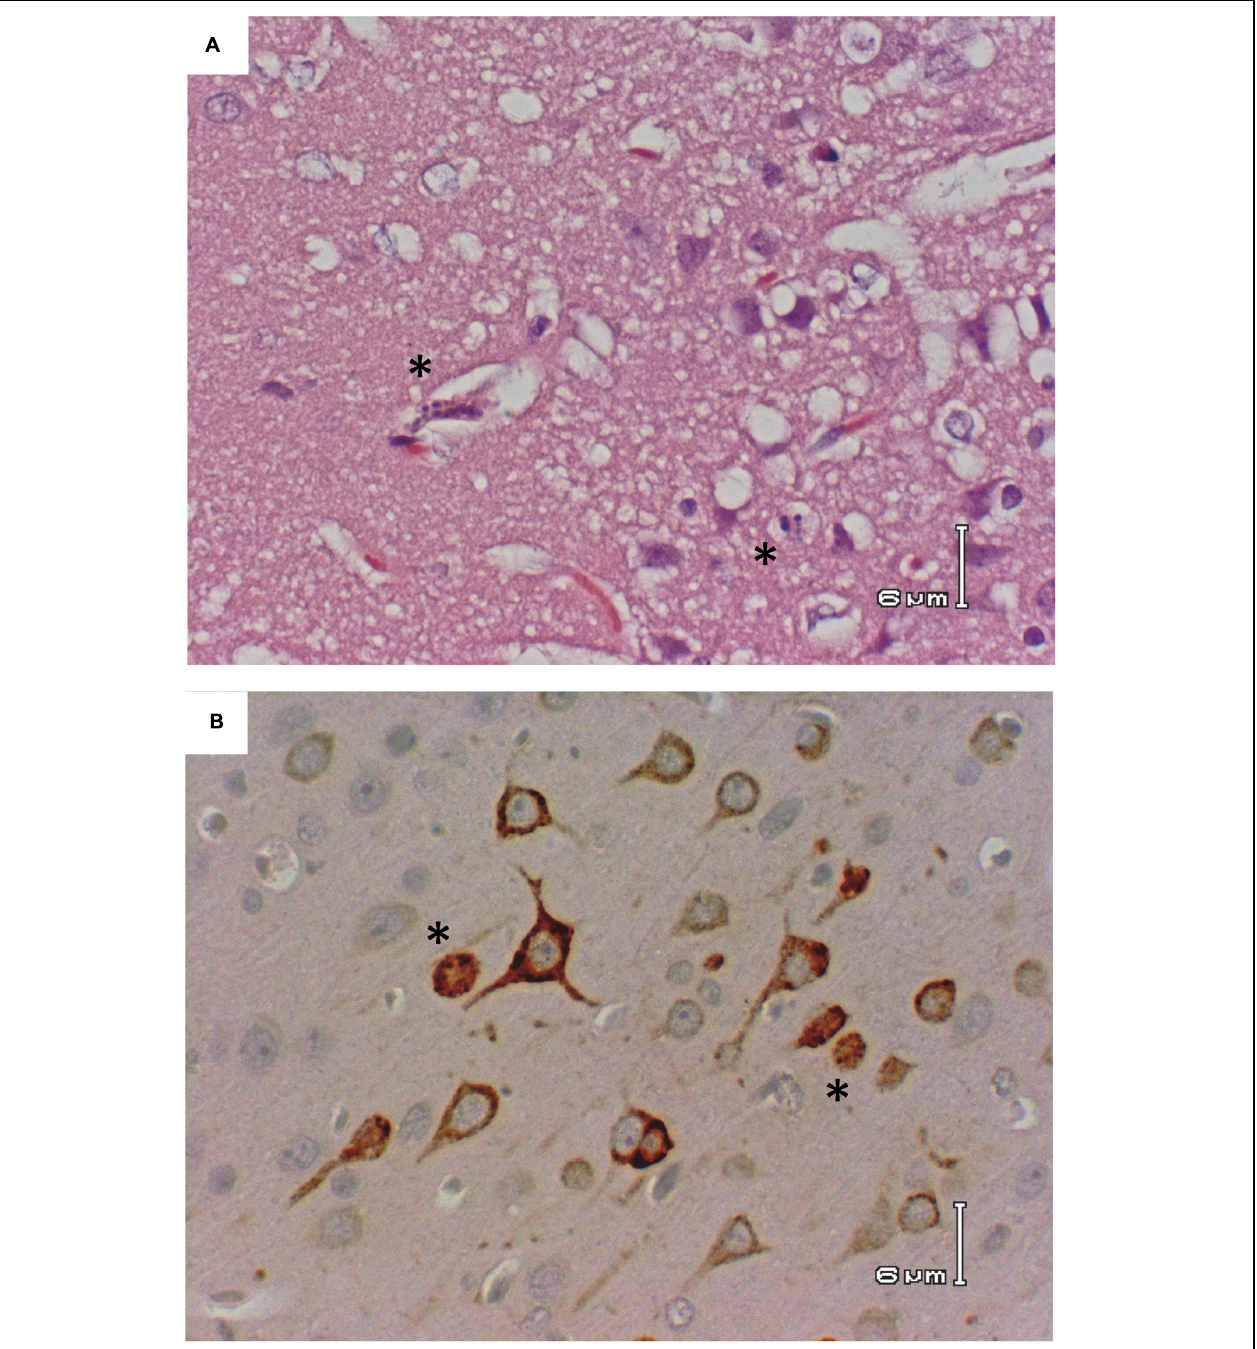
FIGURE 5 | Apoptotic morphology of cortical neurons. Rat R818 taken 7 dpi. (A) H&E; cerebral cortex with morphologically apoptotic cells (asterisks). (B) IHC; RVFV Ag + neurons in the cerebral cortex, two with apoptotic appearance